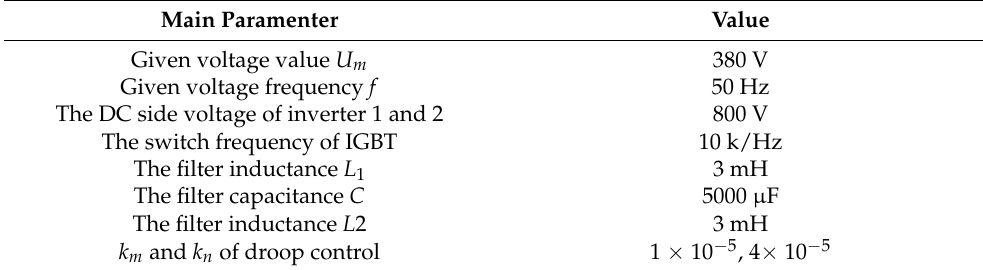
Table 6. The main parameters of the simulation